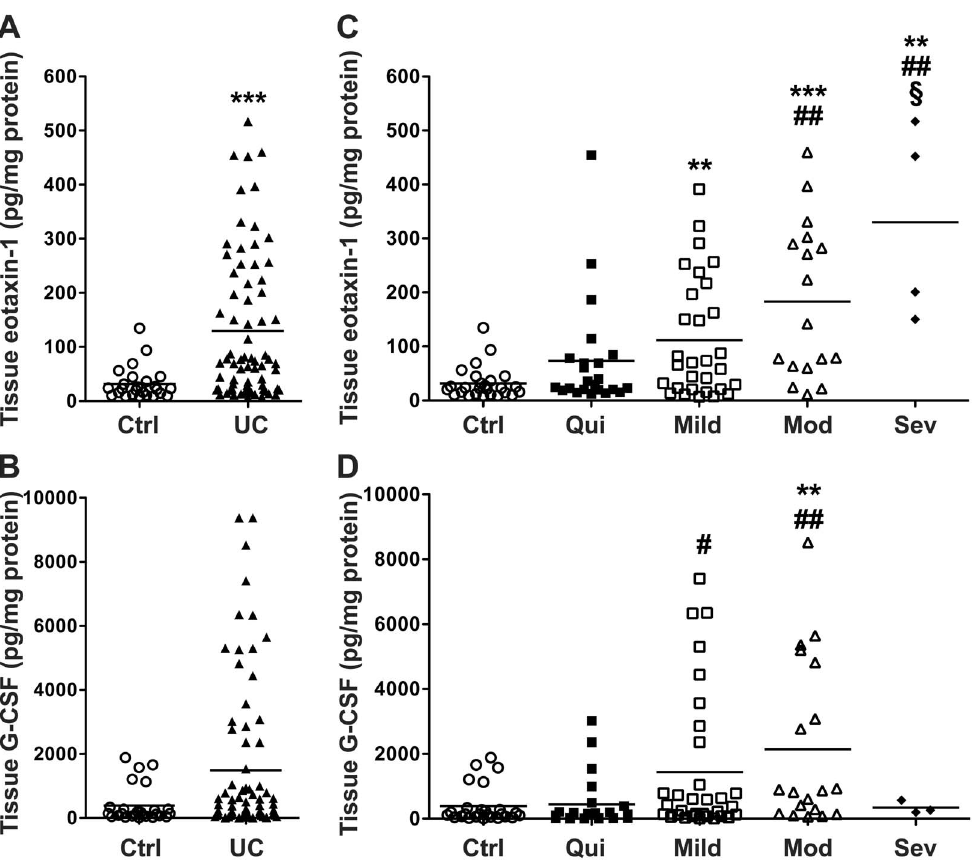
Figure 2. Colon tissue eotaxin-1 is significantly increased in UC. Snap frozen colonic biopsies were lysed and cytokine/chemokine levels were measured by Luminex technology, with each sample corrected for tissue lysate protein concentration, all as described in the Methods. (A) Eotaxin-1 and (B) G-CSF concentration in control and all UC patients. (C) Eotaxin-1 and (D) G-CSF concentration in UC tissues stratified by histologic disease severity, and in control subjects. n =34 for control, and n =86 for UC. ** p , 0.01; *** p , 0.001 vs. control. # p , 0.05; ## p , 0.01 vs. quiescent colitis. 1 p , 0.05 vs. mild colitis.